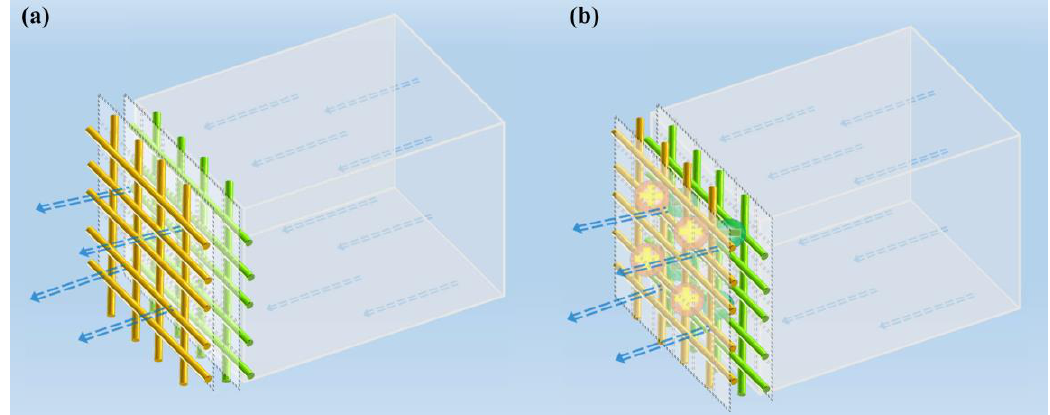
Figure 2. Test schematic diagram of the composite nanofiber membranes: ( a ) non-charged membrane and ( b ) self-powered membrane.